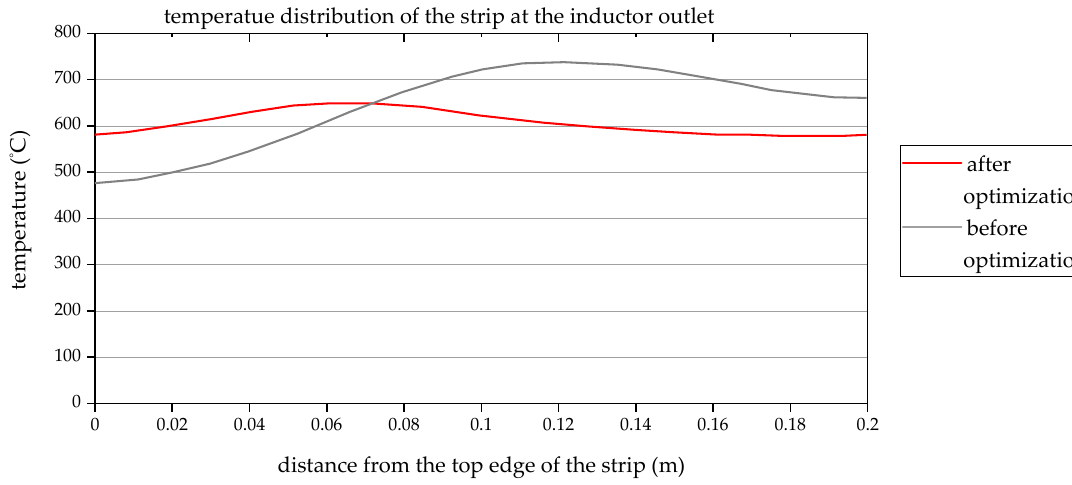
Figure 7. Comparison of temperature distribution before and after optimization.